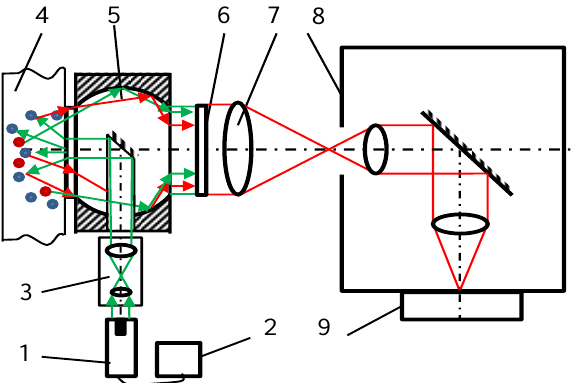
Fig.1. Structural and fundamental scheme of the setup for in vivo Raman spectroscopy by ellipsoidal reflectors: green colour – incident light; red colour – Raman scattering; 1 – laser light source; 2 – power regulator; 3 – optical collimator; 4 – biological object; 5 – optical block with ER; 6 – filter; 7 – lens; 8 – spectrograph; 9 – CCD